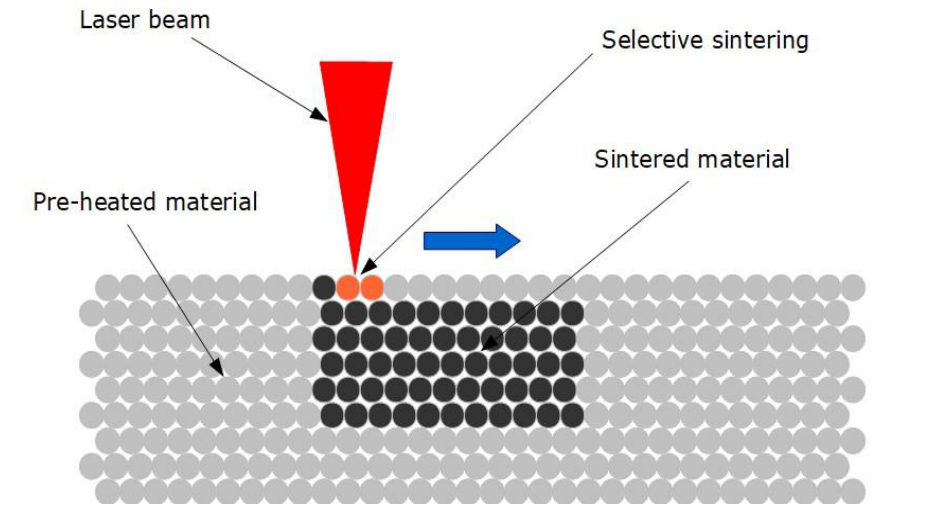
Figure 2. Conceptual scheme of the sintering